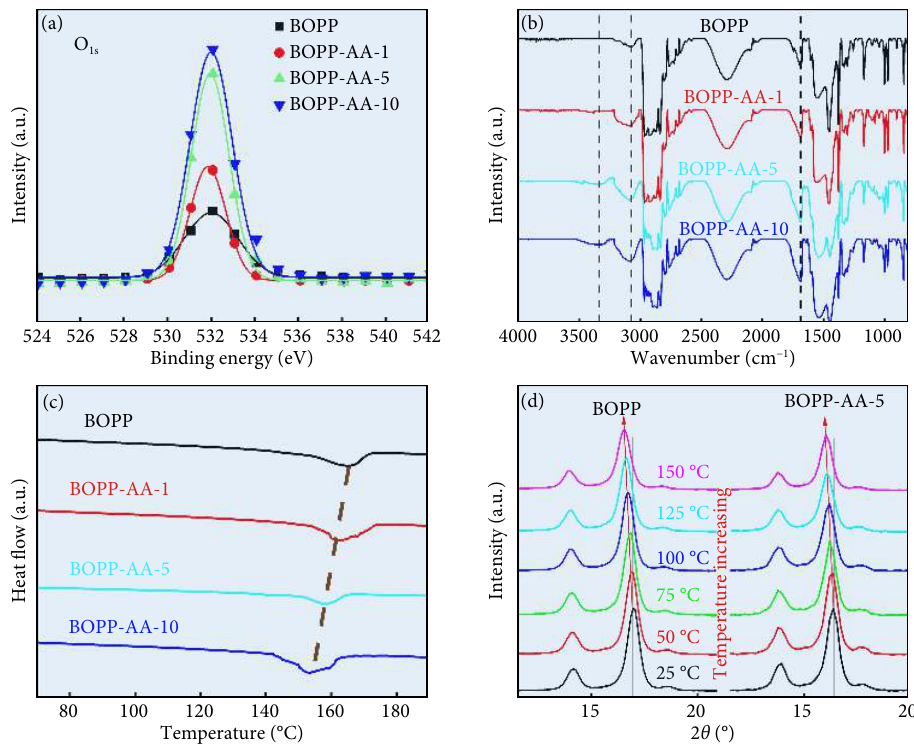
Fig. 3 Microstructure of the BOPP–AA films. (a) XPS, (b) FTIR, and (c) DSC. (d) XRD at different temperatures of BOPP and BOPP–AA-5 films improves from 493.2 to 532.1 kV/mm at